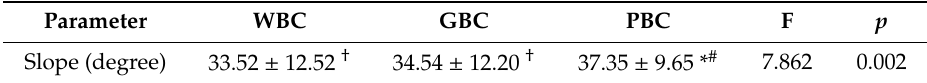
Table 4. Comparison of sacral alignment according to backpack carriage and type.